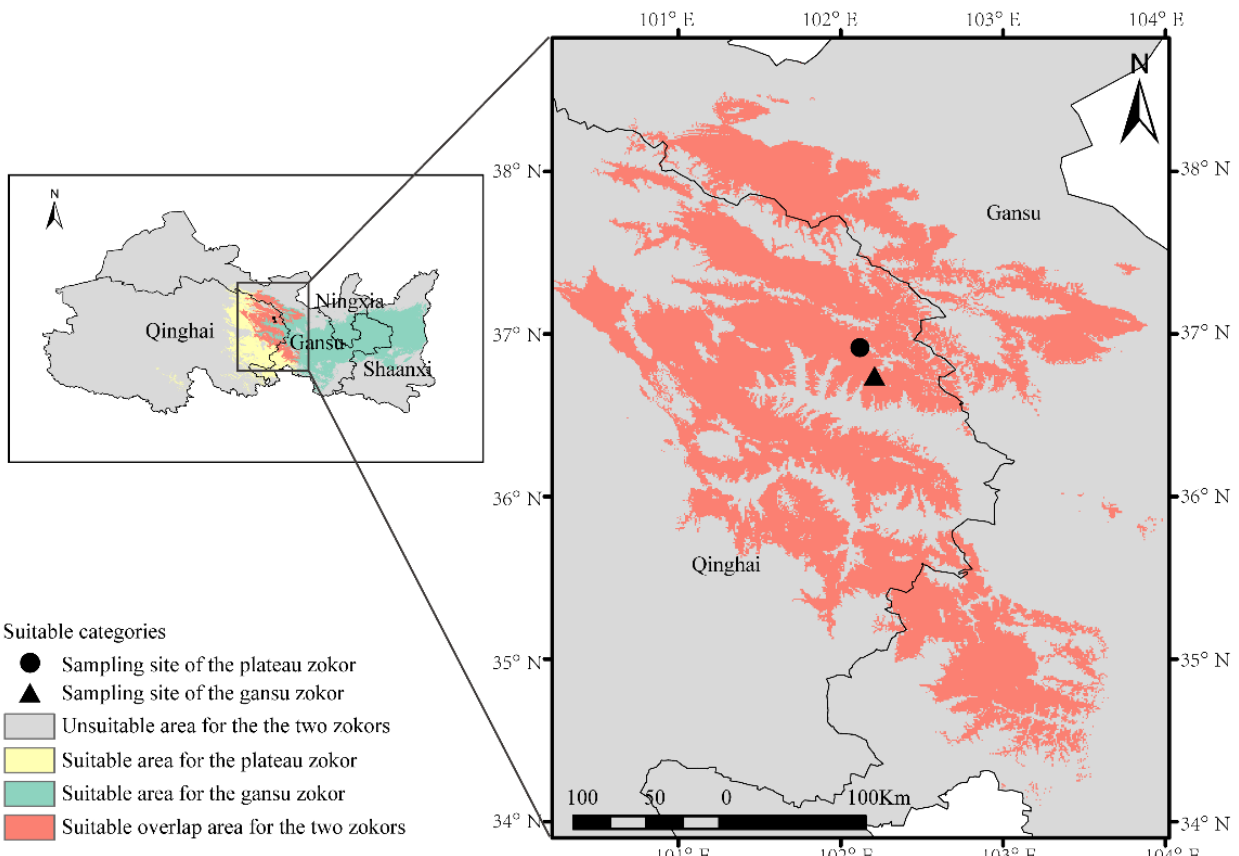
Figure 1. Habitat suitability analysis and the sampling sites of the plateau zokor and the Gansu zokor.